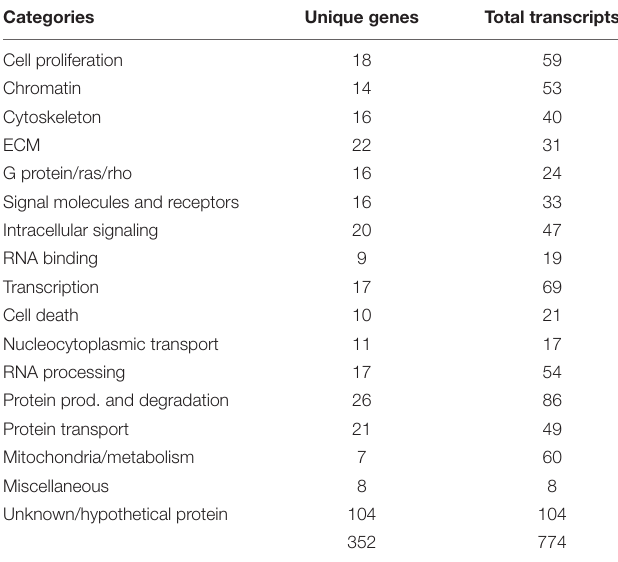
TABLE 1 | Genes isolated from screen comparing HH16 with HH19